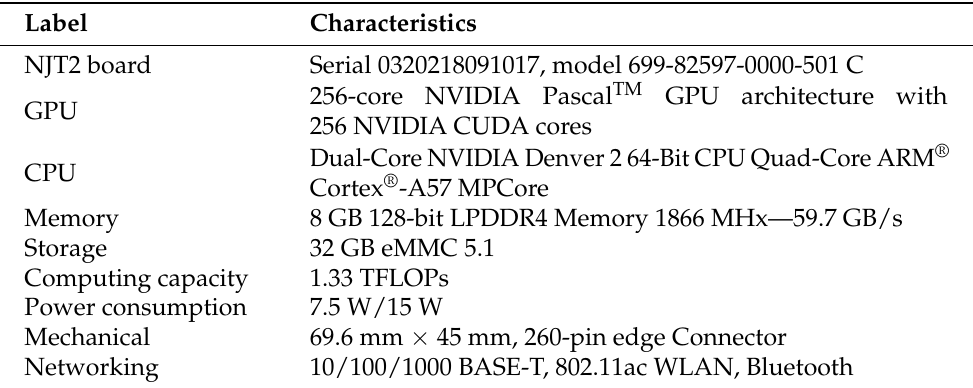
Table 4. NVIDIA Jetson TX2 main characteristics and resources.